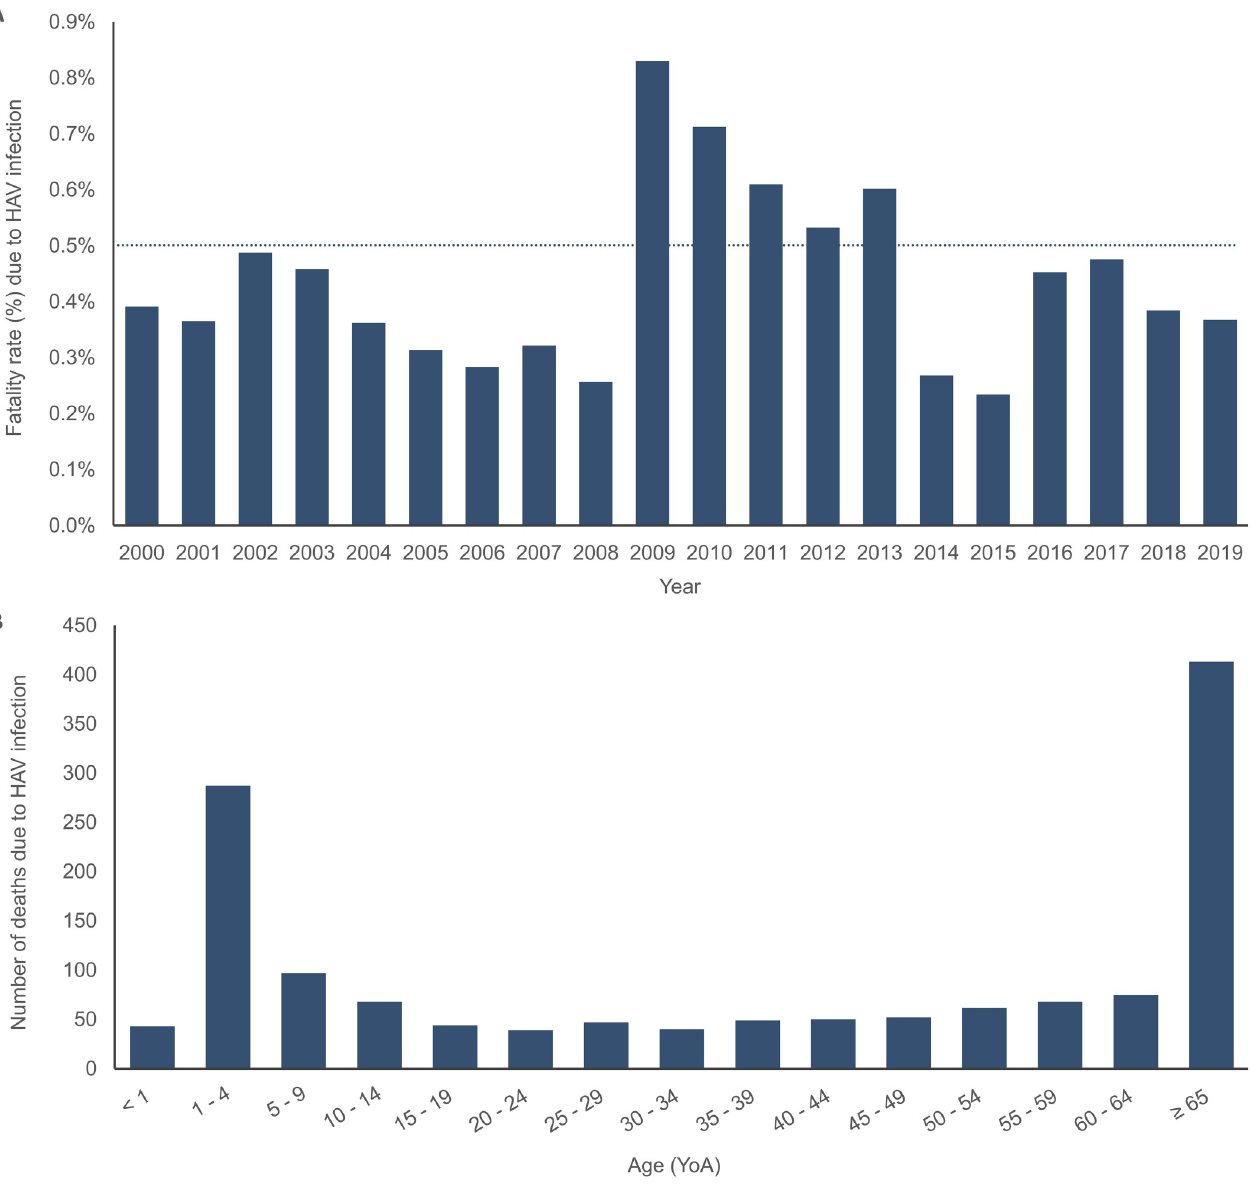
Fig 6. Deaths due to HAV infection by year and age group in Mexico throughout the observation period (2000–2019). A) Fatality rate (%) due to HAV infection by year in Mexico throughout the observation period (2000–2019). B) Total sum of deaths due to HAV infection by age group in Mexico throughout the observation period (2000–2019). HAV, hepatitis A virus; YoA, years of